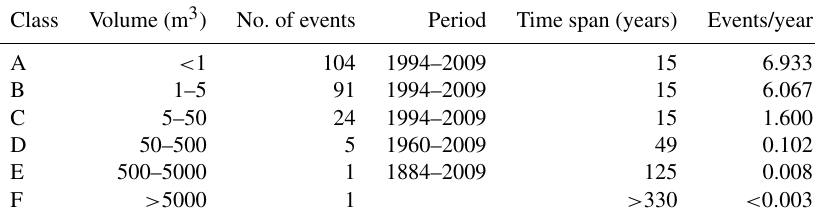
Table 2. Magnitude classes and respective annual frequency for the road connecting Zarautz and Getaria (N-634). Class